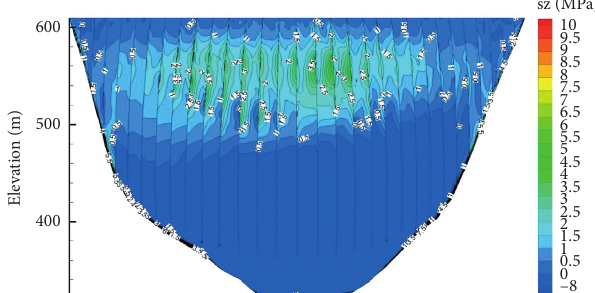
Figure 22: Envelope of maximum static and dynamic vertical stress distributionofupstreamsurfaceofthedamforrelativeslidingcondition.